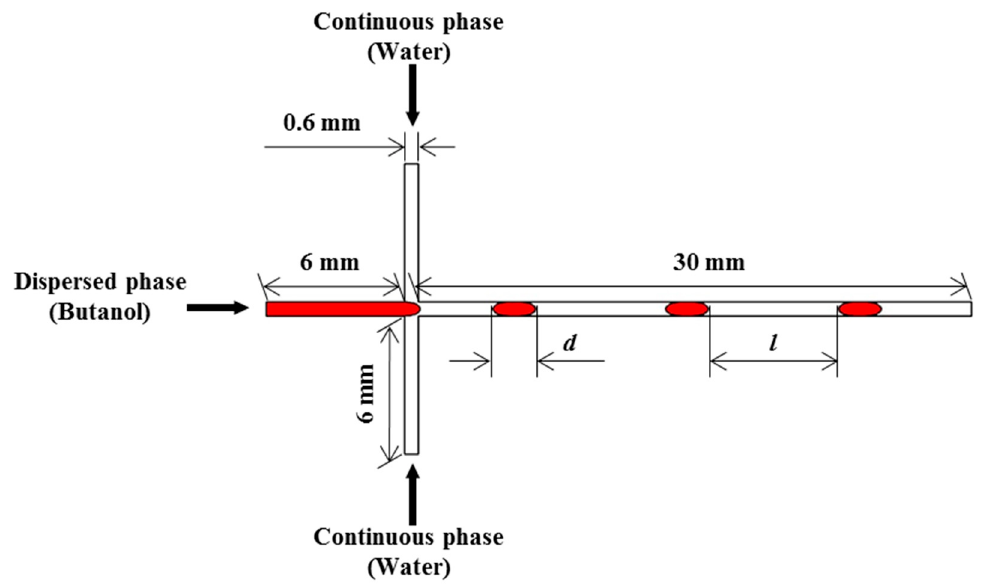
Figure 2. Geometry parameters of the microchannel.